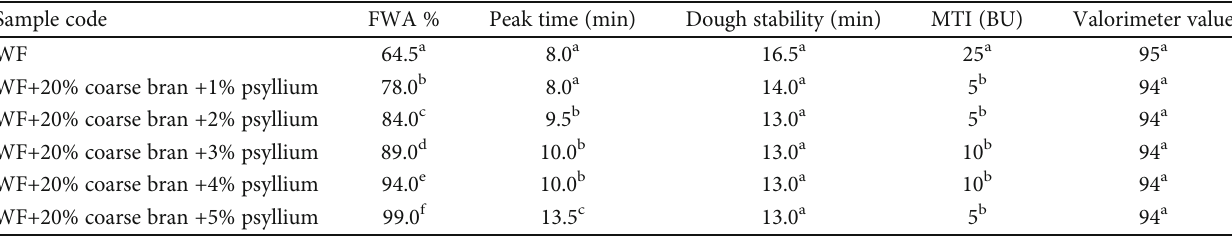
Table 6: Farinograph characteristics of dough made from fl our, coarse bran, and psyllium blends.